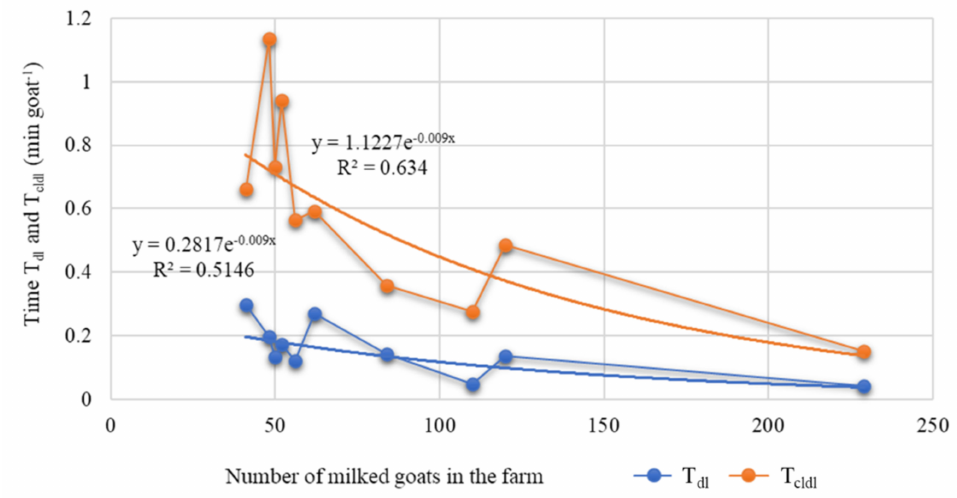
Figure 2. Average specific time T d1 (min) of stay of goats group in a milking parlor and average specific total time T c1d1 (min) of a single milking operation at analyzed goat farms, calculated per one